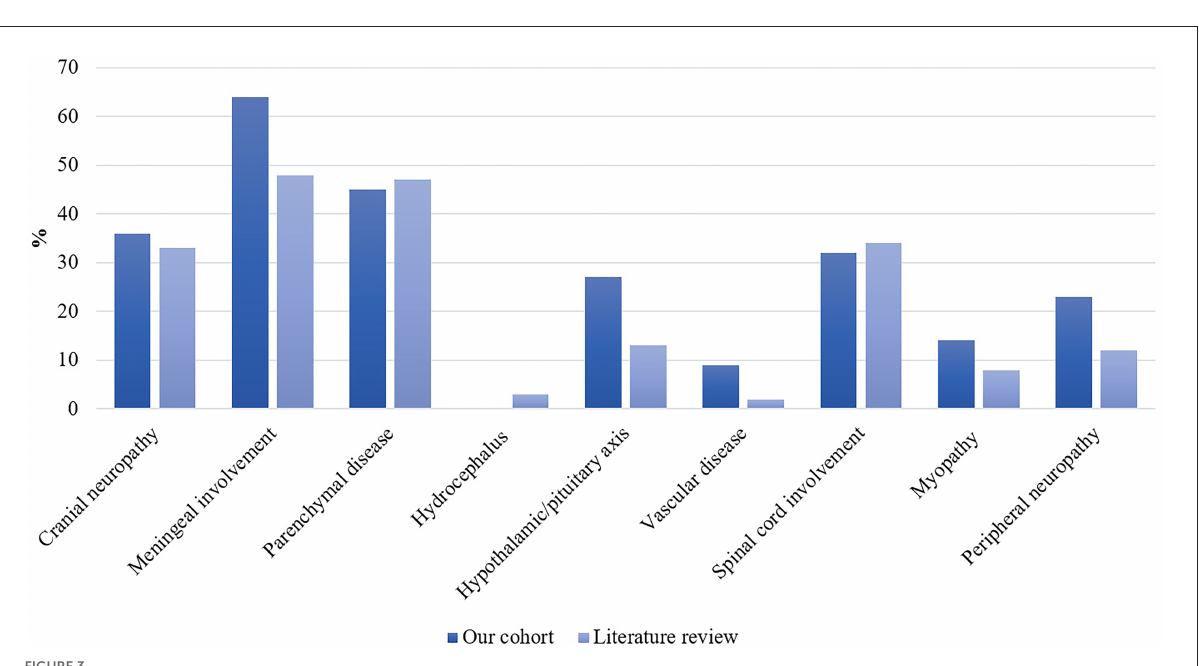
two patients; one was treated with methotrexate alone and one with ABVD (Doxorubicin, Bleomycin, Vinblastine, and Dacarbazine) for concomitant mediastinal lymphoma. Sixteen